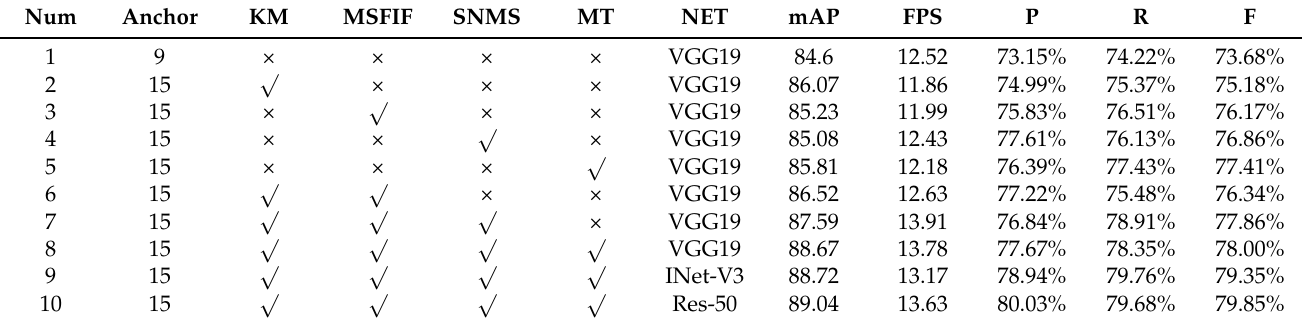
Table 2. Effect comparison of model promotion by different